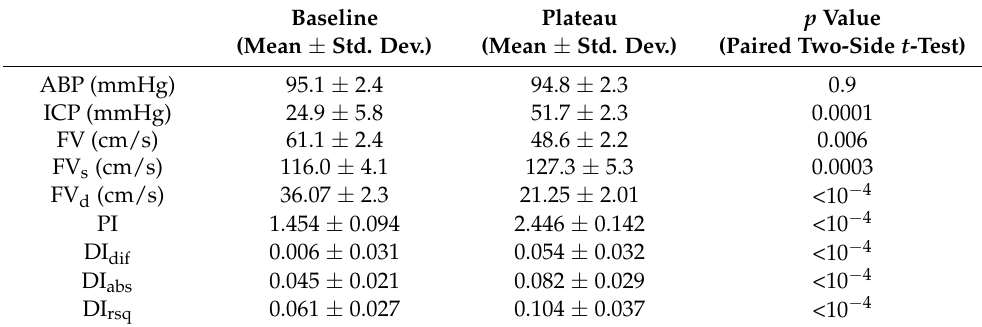
Table 1. Basic characteristics of physiological parameters at baseline and during ICP plateau wave.